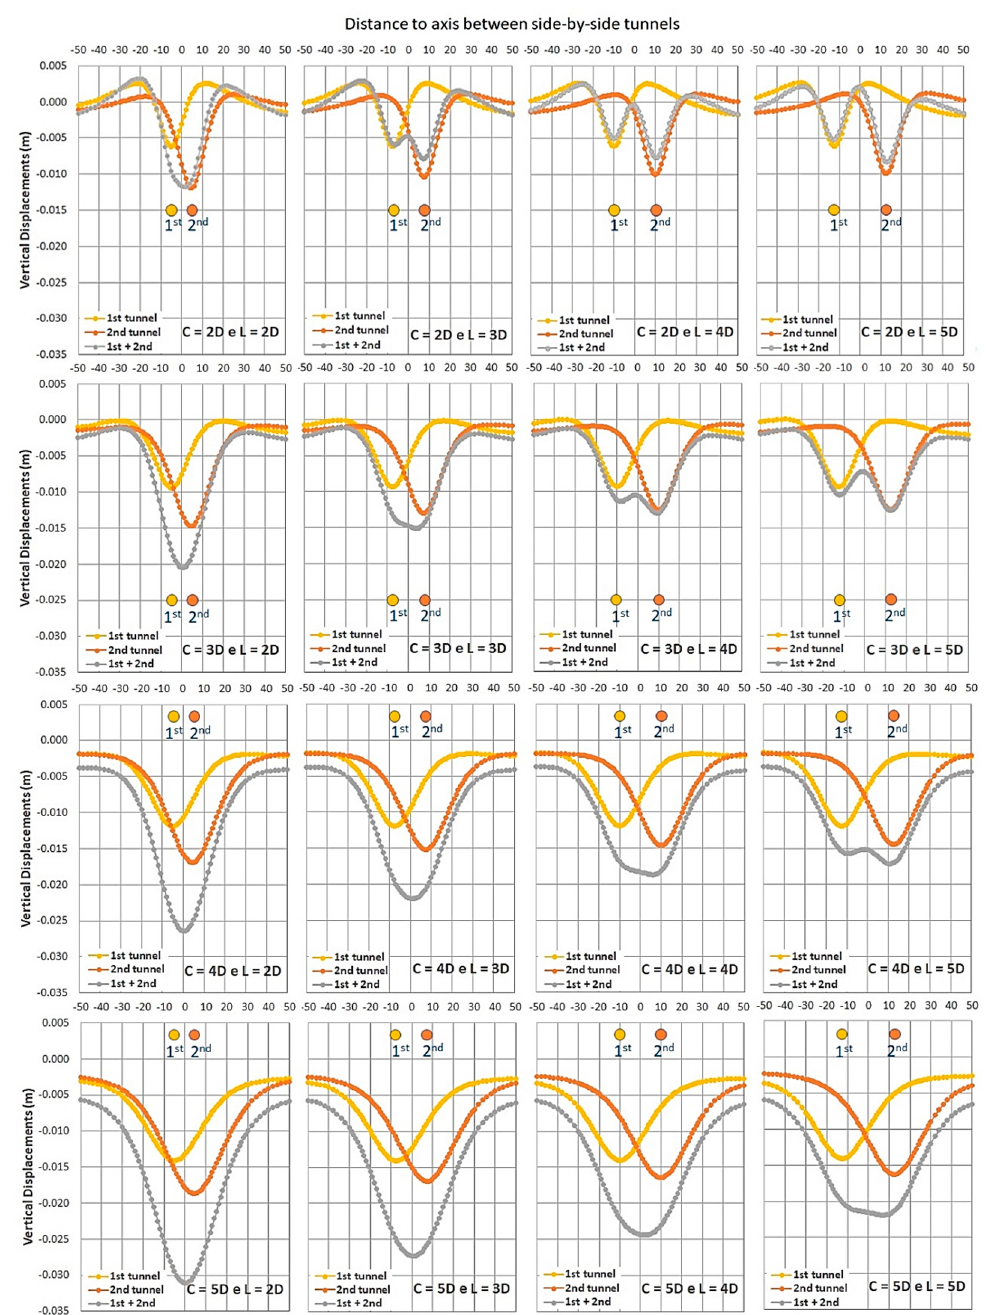
Figure 5. Numerical analysis settlement troughs.